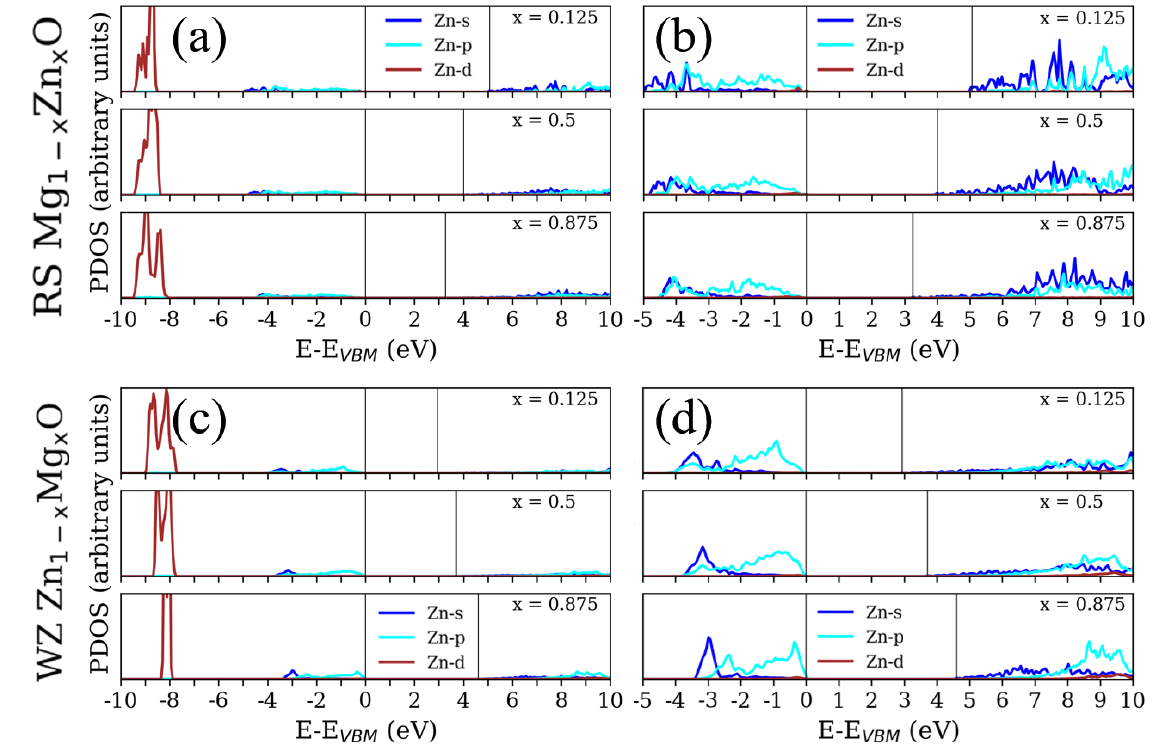
Figure 5. Partial density of states (PDOS) for ( a , b ) rocksalt (RS) Mg 1 − x Zn x O and ( c , d ) wurtzite (WZ) Zn 1 − x Mg x O at different concentrations (x = 0.125, 0.5 and 0.875) with respect to the valence band maximum (VBM). The colors of blue, cyan and brown correspond to the Zn– s , Zn– p and Zn– d states, respectively. The PDOS of ( a , c ) are scaled by a factor of 1/3 in comparison with ( b , d ) and Figure 4. One vertical solid line is the VBM at 0 eV, and the other vertical solid line is the conduction band minimum above 0